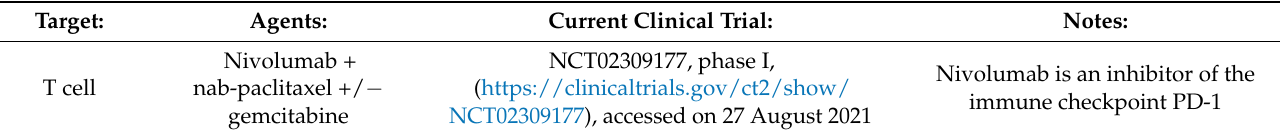
Table 2. Clinical Trials of Agents Targeting the PDAC Tumor